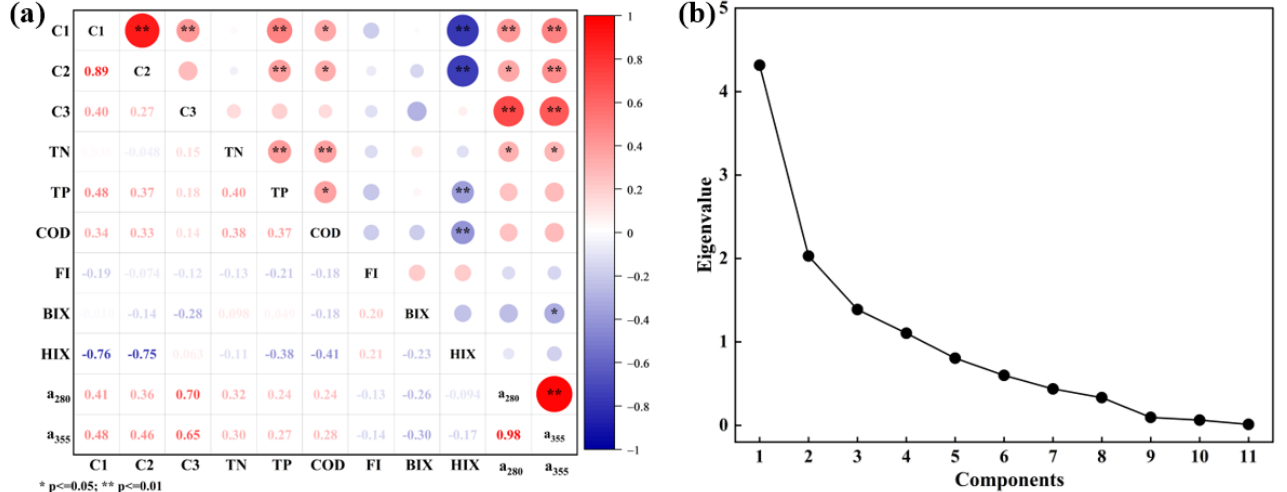
Figure 7. ( a ) Correlation analysis of DOM components and various water − quality indices in the Wanggang River; ( b ) Eigenvalues of principal components of DOM components and water-quality indices in the Wanggang River.